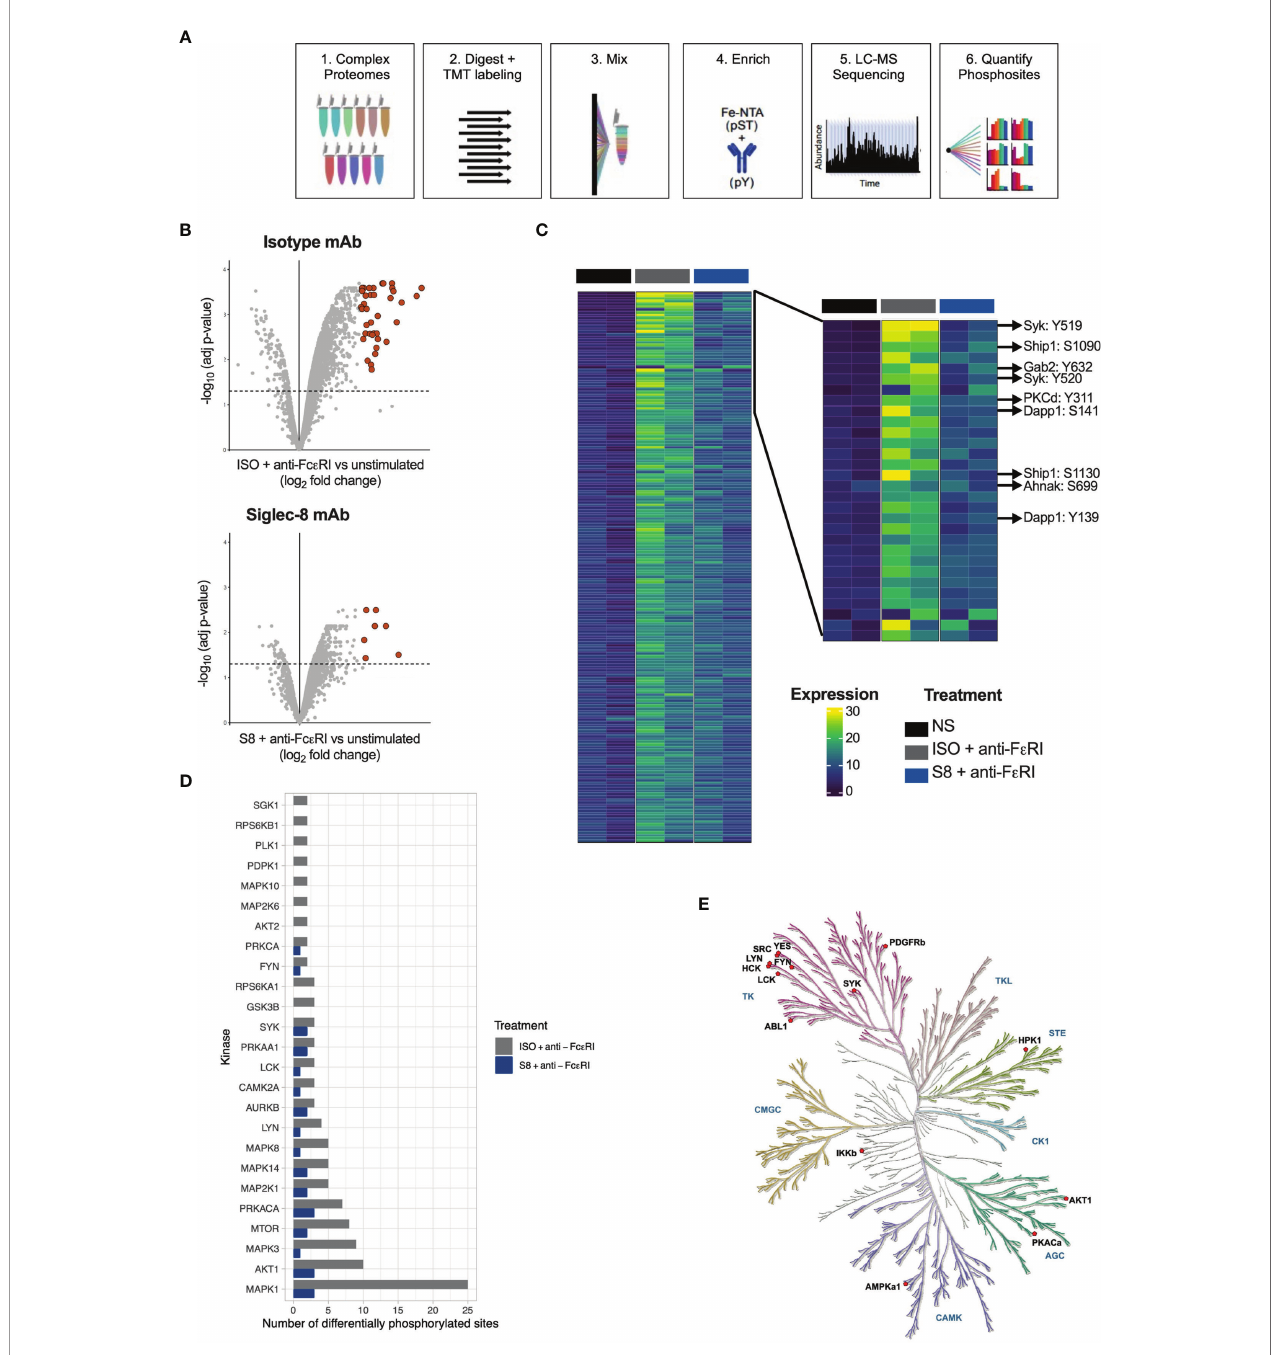
FIGURE 2 | Phospho-proteome of Fc e RI-stimulated and Siglec-8-inhibited S8-BMMCs. (A) Schematic of the process for determining phospho-proteomes of MCs. (B) Volcano plots of Log2 fold change against statistical signi fi cance of the abundance of phospho-peptides 2 min after Fc e RI crosslinking in the presence of isotype control antibody (top panel) or Siglec-8 mAb (bottom panel). Highlighted are the peptides upregulated more than 4-fold. (C) Heatmap of quanti fi ed phospho-peptides. Each line represents a unique phospho-peptide with the fi rst two columns representing the unstimulated MCs in two independent experiments, the next two columns the phospho-proteome from MCs activated through Fc e RI and the last two columns represent activation in the presence of a Siglec-8 mAb. The heatmap is ranked from top to bottom by fold induction upon activation averaged over the two experiments. Right panel: zoom in on the top sections of the heatmap in (C) . (D) Bar graph representing the number of phosphosites predicted to be phosphorylated by the indicated kinase in the Fc e RI stimulated conditions. (E) Kinase tree highlighting the kinases that are known to modify sites that showed differential phosphorylation between the isotype and Siglec-8 mAb conditions upon Fc e RI